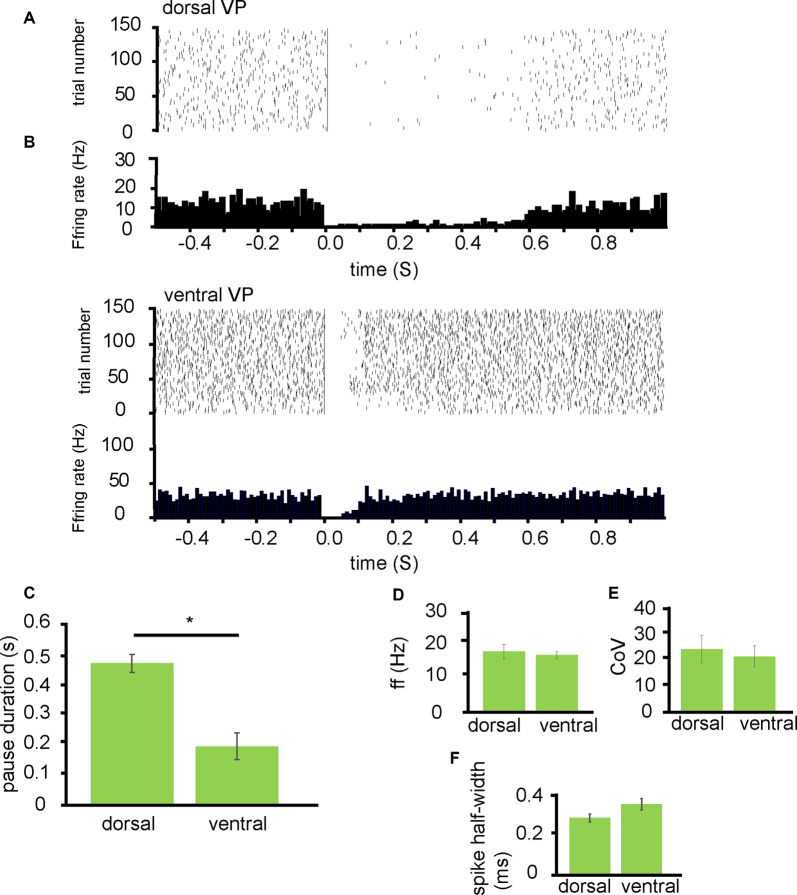
NAc stimulation induces a longer pause duration in dorsal VP neurons than ventral. All experiments presented in this figure used the first stimulation protocol (one stimulation of 200 μs duration followed by a 10-s gap) identified in the “Materials and Methods” section. (A) A typical example raster plot of tonic firing activity in a VP neuron 0.5 s pre-stimulation and 1.0 s post-stimulation of the NAc. The raster plot exemplifies one neuron’s response in the dorsal VP during 150 applications of stimulation. (B) A typical example raster plot of tonic firing activity in a VP neuron 0.5 s pre-stimulation and 1.0 s post-stimulation of the NAc. The raster plot exemplifies one neuron response in the ventral VP during 150 applications of stimulation. (C) Bar chart representing significant differences (*P < 0.05) in pause duration between those neurons studied in the dorsal VP compared to those in the ventral VP. (D) Firing frequency (Hz) for neurons that paused in response to NAc stimulation in the dorsal VP compared to those in the ventral VP. (E) Coefficient of variation for neurons that paused in response to NAc stimulation in the dorsal VP and those in the ventral VP. (F) Spike half-width (ms) for neurons that paused in response to NAc stimulation in the dorsal VP compared to those in the ventral VP.